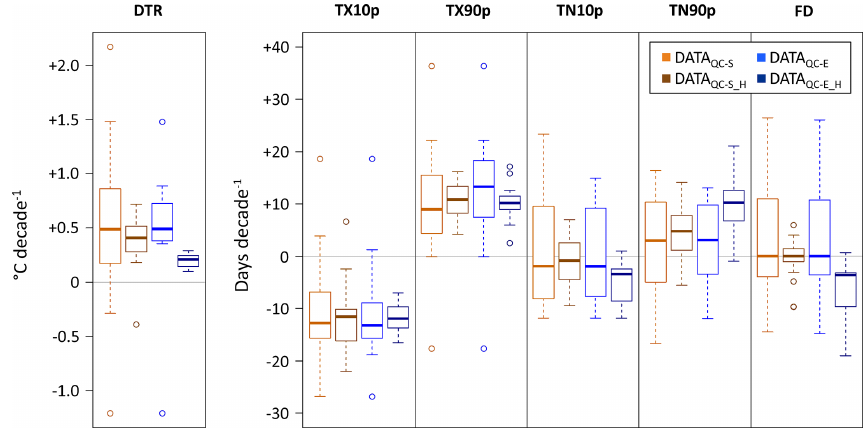
Figure 10. Same as Fig. 9 but for the Altiplano stations ( ≥ 3500ma . s . l . ). Additionally, trends of frost days (FD) are